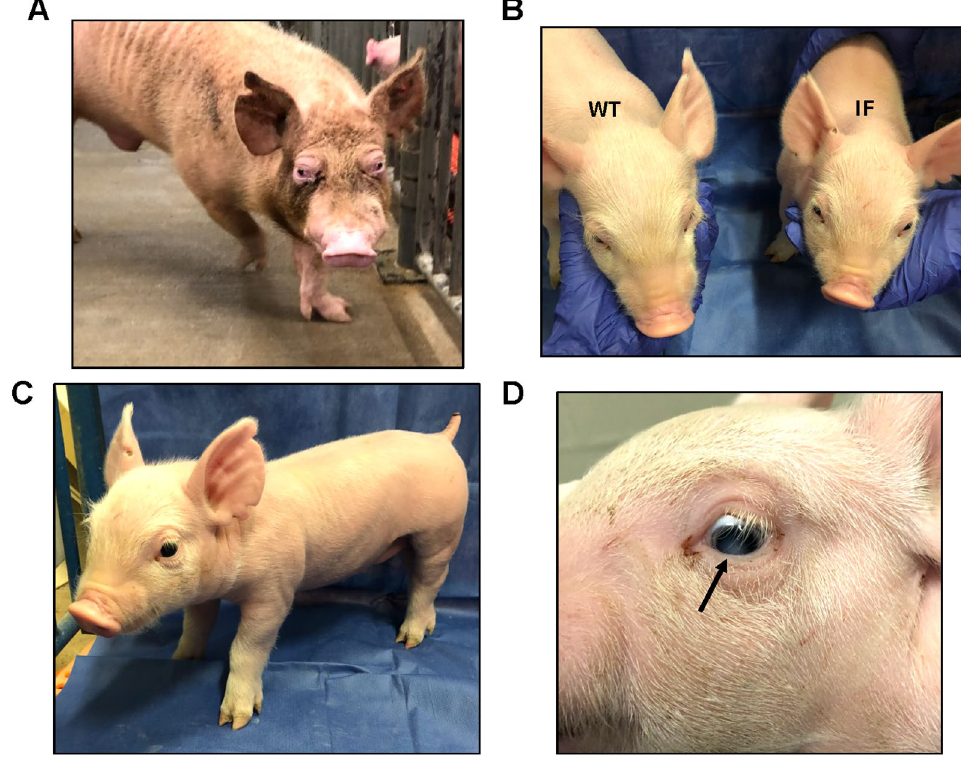
Figure 5. Gross anatomical features of ANTXR1 in-frame (IF) pigs for the second SVA challenge. ( A ) The founder boar who was used for breeding was mosaic for edits in ANTXR1 with two knockout alleles and one in-frame (IF) allele (Figure S3), and he exhibited a strong GAPO phenotype. After breeding to propagate his alleles, only the IF mutation was detected in progeny, and piglets were produced that were homozygous for this mutation. As shown, these piglets exhibited ( B ) frontal bossing and shorter snouts and ( C ) a post-legged stance as compared to WT piglets from the same litter. ( D ) Two homozygous IF piglets also had cataracts at birth (black arrow).